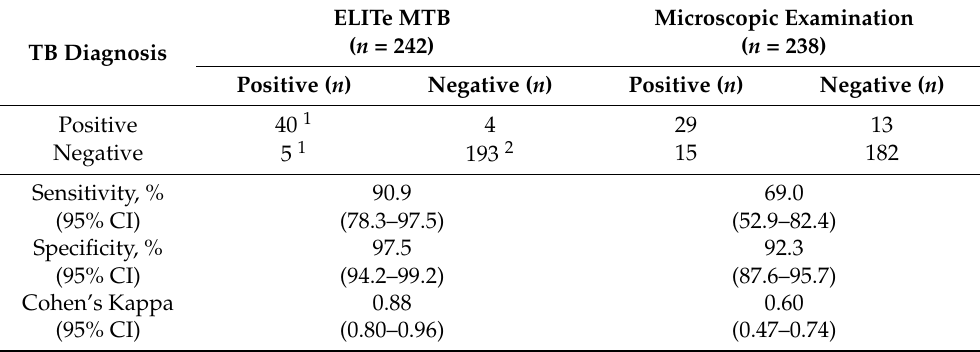
Table 1. Performances of MDR/MTB ELITe MGB ® assay and microscopic examination for the detection of M. tuberculosis complex in specimens in comparison to TB